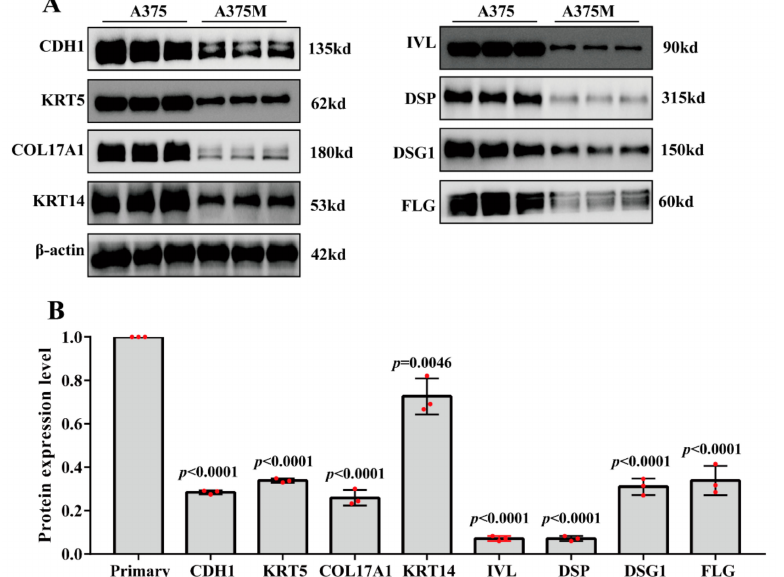
Figure 5. Western blotting staining ( A ) and quantitative analysis ( B ) of CDH1, KRT5, COL17A1, KRT14, IVL, DSP, DSG1, and FLG between metastatic melanoma cells and primary melanoma cells. β -actin served as the internal control. Data are means ± s.d., n ≥ 3; p value < 0.05 was considered significant, t